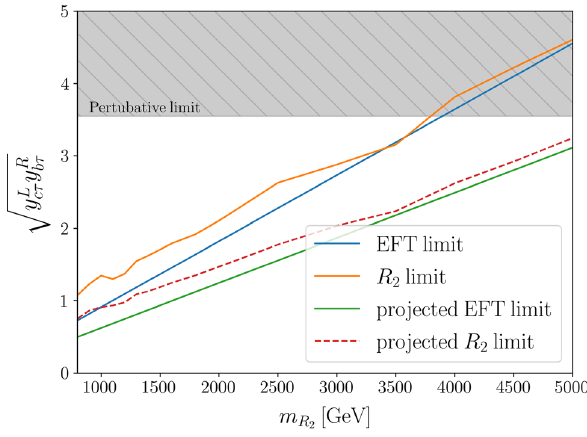
(cid:21) y L c τ y R as a function of the R 2 mass b τ